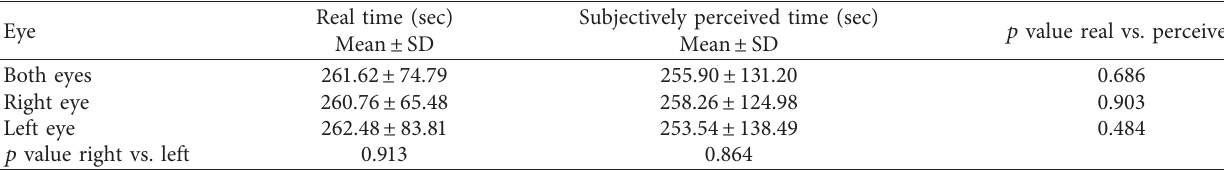
Table 3: Comparison of perception of time of surgery in the control subgroup (without change of any parameter between right and left eye): mean ± SD; p values of paired t -test between right and left eye and between real and subjectively perceived time. Eye